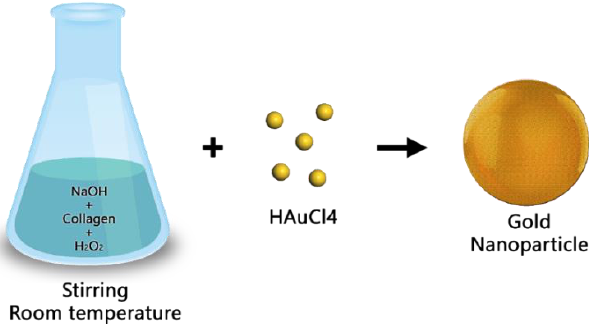
Figure 1. A schematic overview of the clg-AuNPs synthesis process.